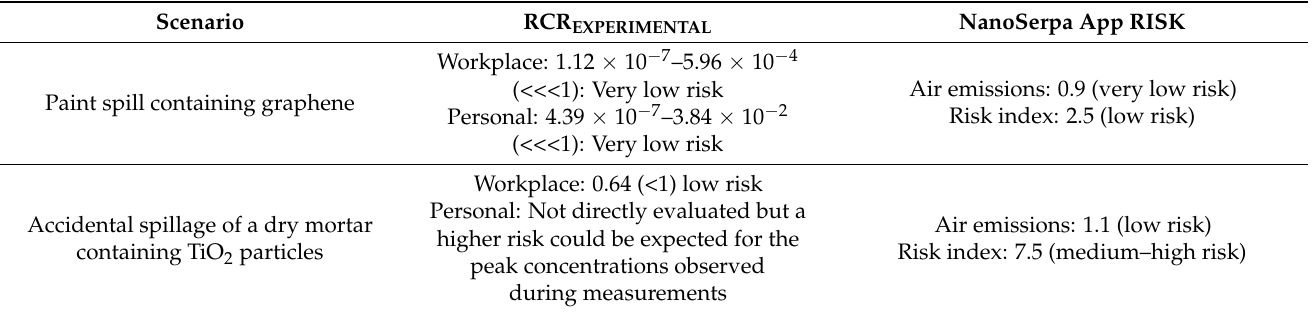
Table 7. Comparison of the risk obtained with the NanoSerpa app and the RCR values obtained from experimental measurements. Scenario RCR EXPERIMENTAL NanoSerpa App